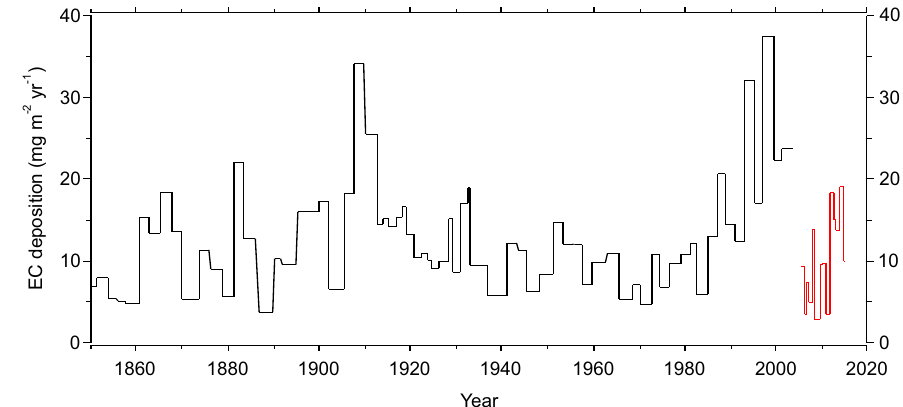
Figure 8. EC deposition at Holtedahlfonna between 1850 and 2015. EC deposition (mgm − 2 yr − 1 ) in the 2005 ice core (black curve; Ruppel et al., 2014) and in the shallow firn core (red curve) collected from different sites (see Fig. 1) on